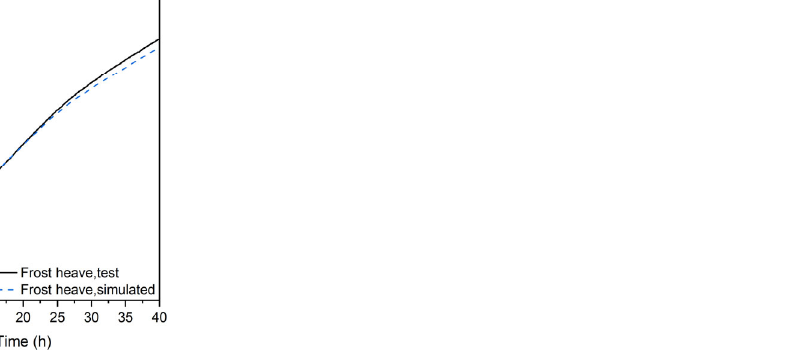
Figure 7. Comparison of the measured and simulated values of hydrothermal variations and deformation processes in one–sided freezing tests: ( a ) comparison of the total volumetric water contents at different moments, ( b ) comparison of the temperatures at different moments, and ( c ) comparison of the variations in the frost heave.